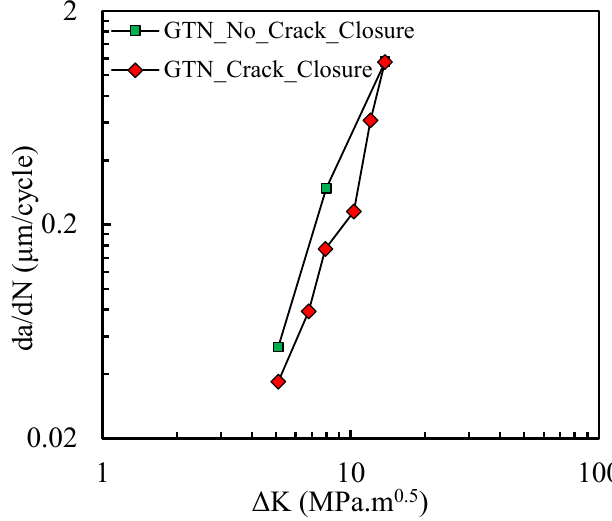
Figure 10. Effect of crack closure on da/dN values (model with GTN).